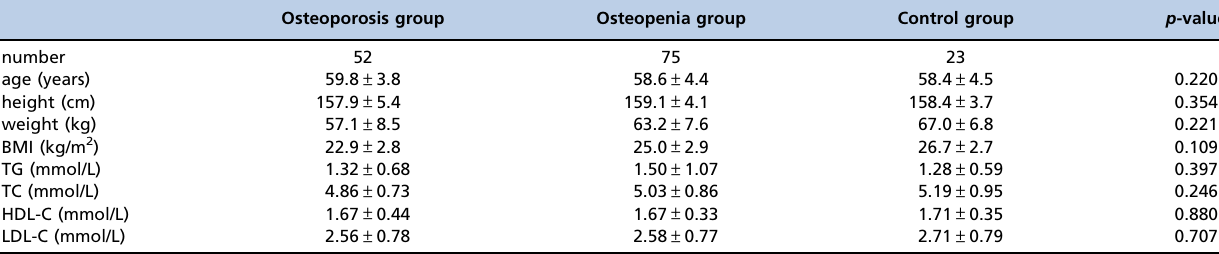
Table 1 - Demographic characteristics of the